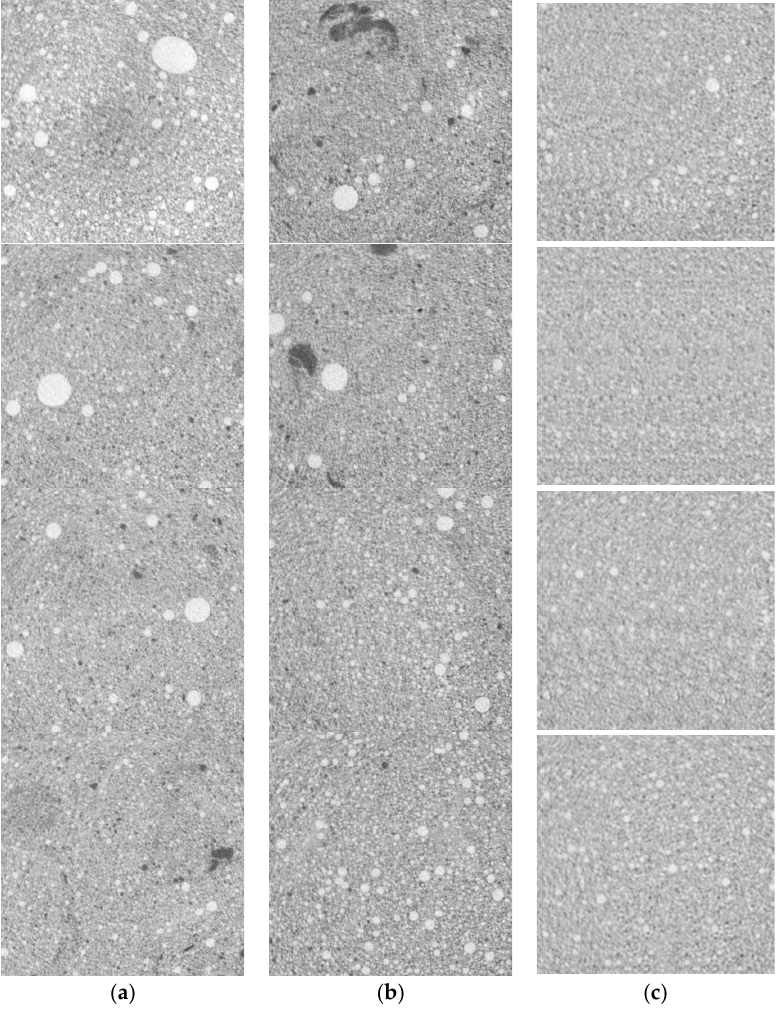
Figure 4. XCT reconstructions of foam concrete structure: ( a ) Type 1 ; ( b ) Type 2 ; ( c ) Type 3